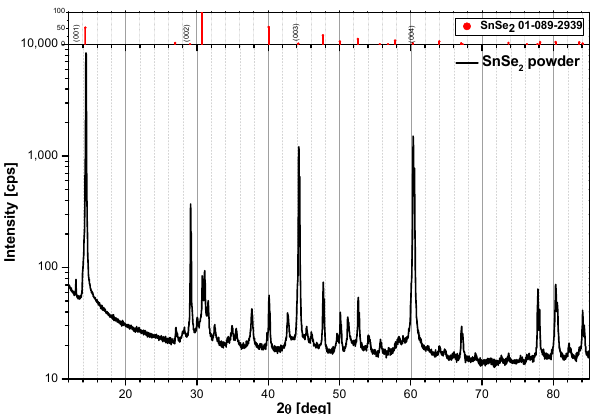
Figure 1. XRD diagram for the SnSe 2 powder.